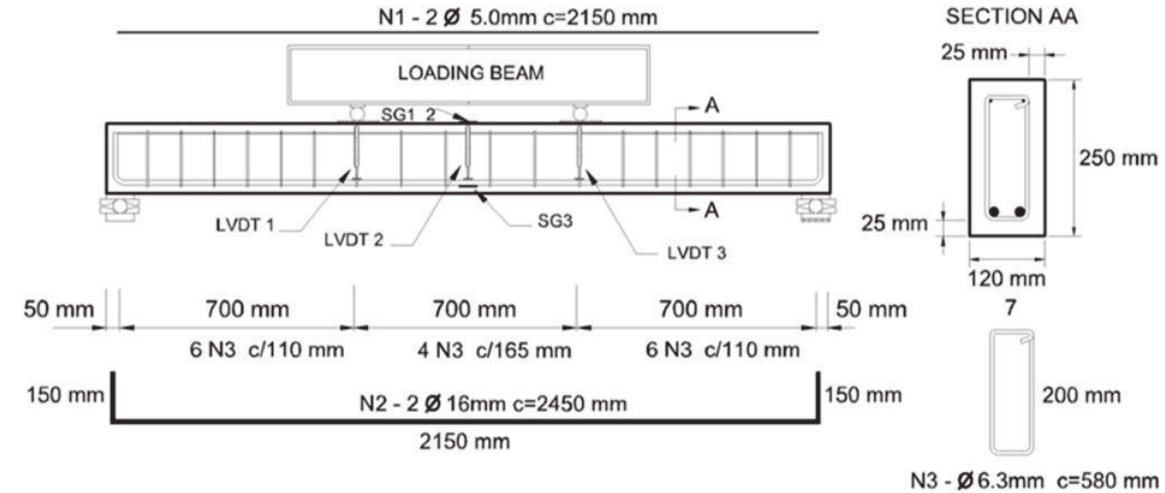
Figure 1 Schematic representation of bending tests performed with prepared reinforced beams